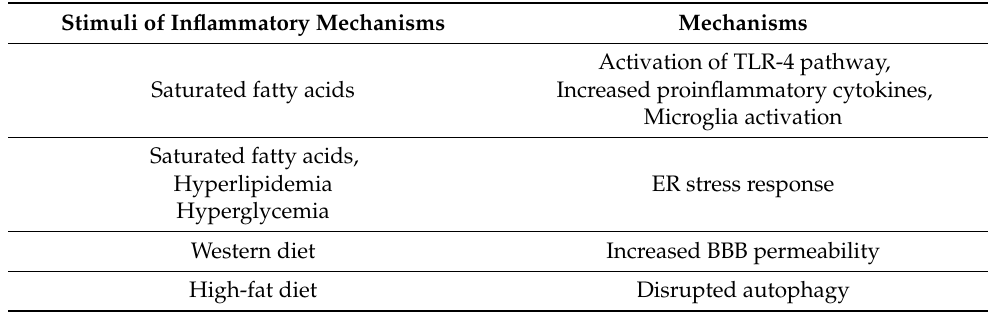
Table 1. Proposed mechanisms leading to obesity-induced hypothalamic